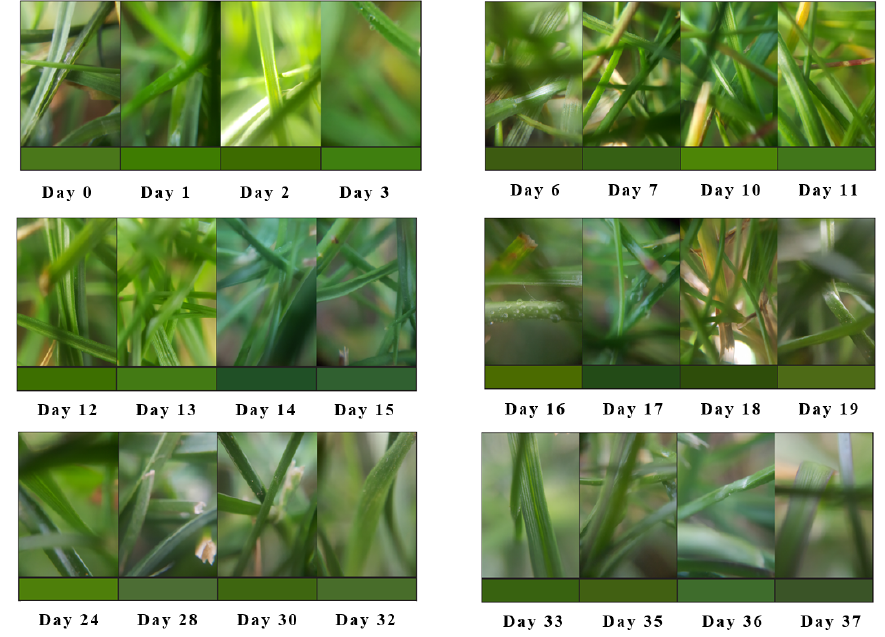
Images of grass growth on uncontaminated soil